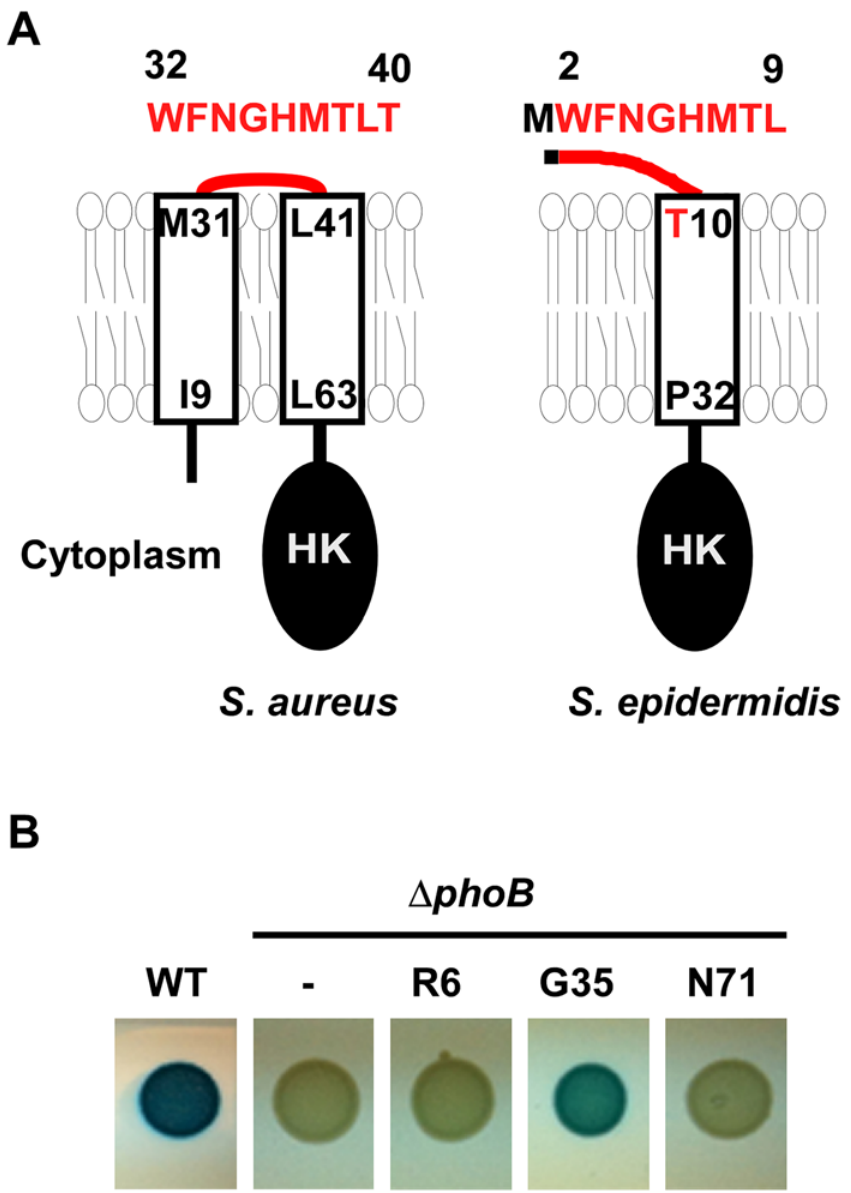
Fig 1. The topology of the N-terminal domain of SaeS. (A) The predicted topologies of the N-terminal domain of SaeS in S . aureus and S . epidermidis . Transmembrane helices were shown as rectangles, where the terminal amino acids and their positions are indicated. The amino acid sequence of the linker peptide is shown in red above the topology model with the amino acid positions. HK, histidine kinase domain. (B) The confirmation of surface exposure of Gly35 in the linker peptide. The phoB gene was inserted into saeS in the single copy plasmid pCL- saeRS at the position Arg6 (R6), Gly35 (G35), and Asn71 (N71); then the plasmids were inserted into the phoB -deletion mutant of S . aureus strain Newman (NM Δ phoB ). The test strains were grown on a tryptic soy agar containing XP (5-Bromo-4-chloro-3-indolyl phosphate). WT, wild type; Δ phoB , phoB- deletion mutant;-, no phoB